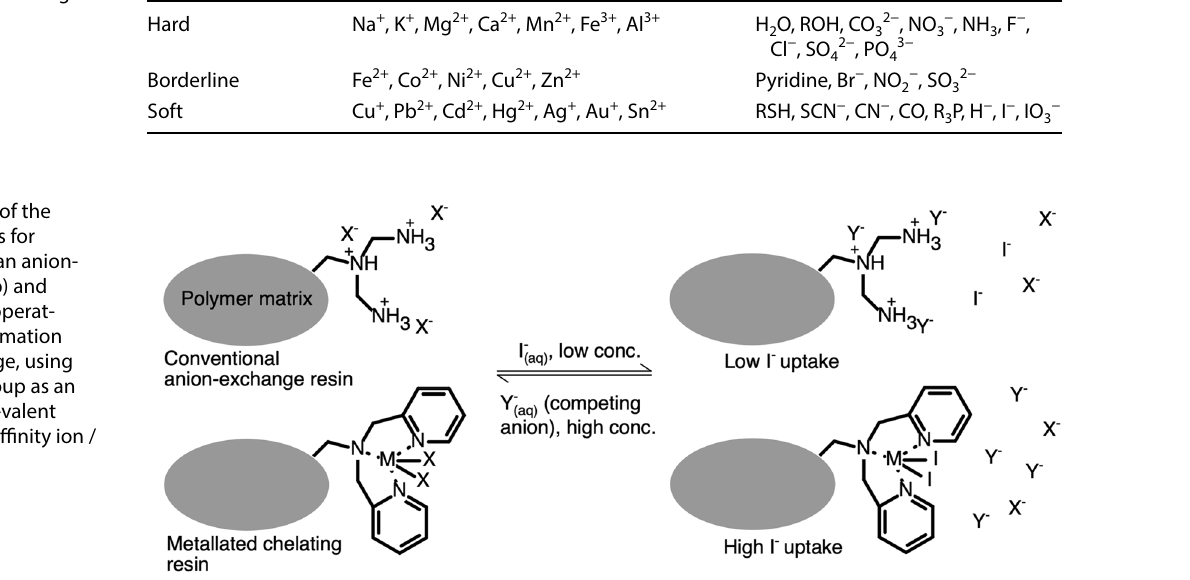
Table 1 Common metals and ligands classified according to HSAB theory